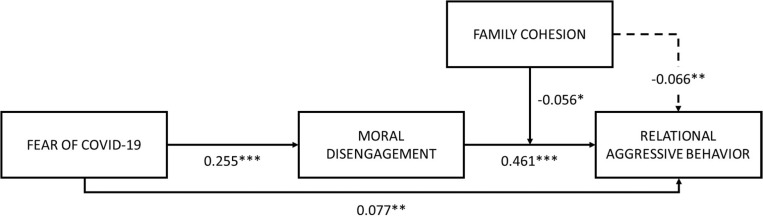
Model 2 Total sample on relational aggression behavior. RMSEA = 0.038, 90% CI [0.035, 0.041], CFI = 0.981, TLI = 0.976, SRMR = 0.035.